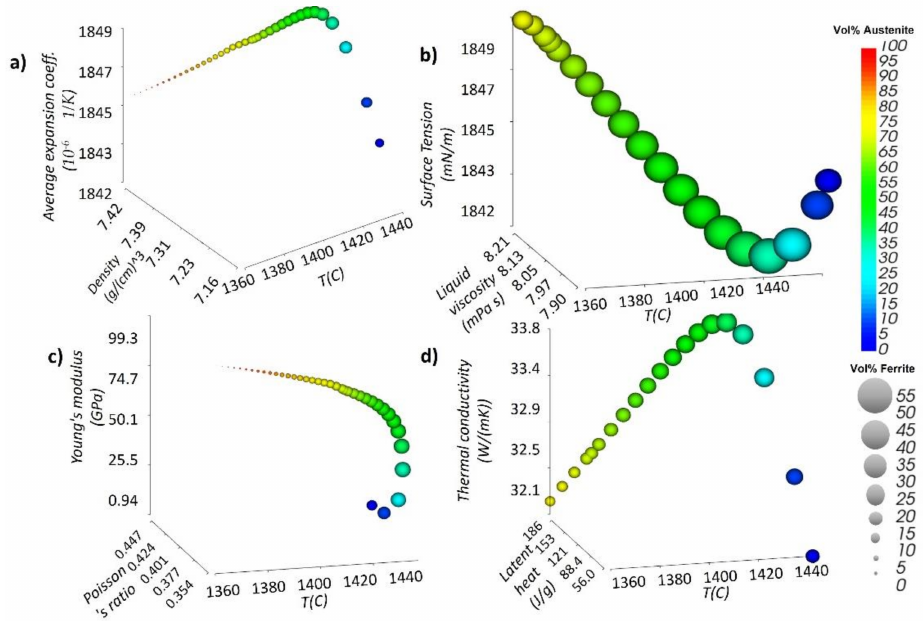
Figure 3. Temperature-dependent properties ( a ) density and average expansion coefficient with temperature, ( b ) Liquid viscosity and surface tension with temperature, ( c ) Poisson’s ratio and Young’s modulus with temperature ( d ) Latent heat and thermal conductivity with